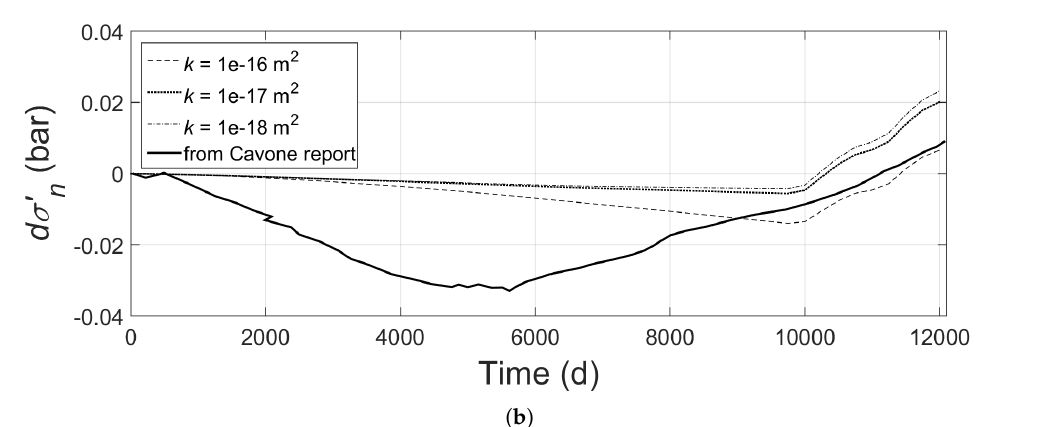
Figure 16. Emergent Mirandola fault and Cavone oilfield modeling: Coulomb stress change dCFF (bar) ( a ); effective normal stress change d σ (cid:48) n (bar) ( b ) plotted for variable permeability of the lower caprock layer at a distance of 1 km from the hypocentre in the negative y -axis, on the hanging-wall block.